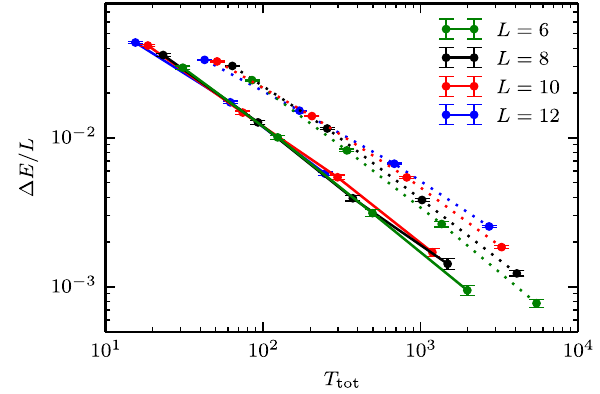
FIG. 3. Energy standard deviation density Δ E=L . Dotted lines are W ¼ 1 ; solid lines are W ¼ 8 . Results have been obtained using exact time evolution to exclude any Trotter errors.